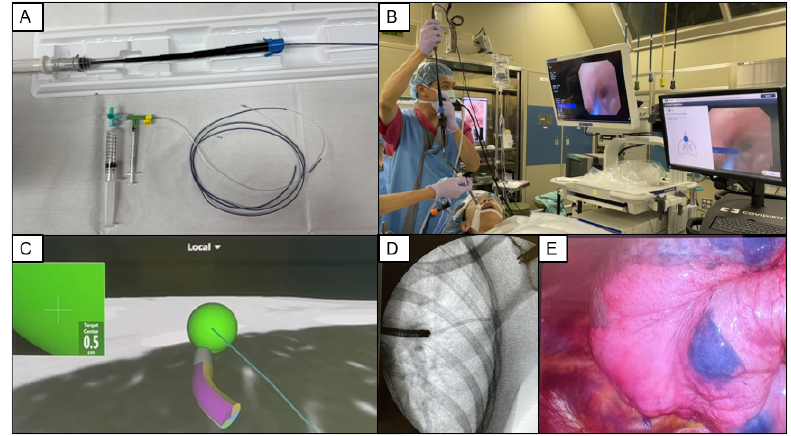
Figure 2. Steps of electromagnetic navigation bronchoscopy virtual-assisted lung mapping. ( A ) Locat- able guide (LG)-containing sensor and metal-tipped catheter are used for electromagnetic navigation bronchoscopy (ENB) lung mapping. ( B ) The LG is inserted in an extended working channel (EWC) and advanced through the target under real-time navigation. ( C ) Once the LG/EWC reaches the target in the virtual image, the EWC is locked in place, and the LG is removed. ( D ) A metal-tip catheter preloaded with 0.7 mL of indigo carmine is inserted into the EWC under fluoroscopic guid- ance. ( E ) The introduction of ENB to virtual-assisted lung mapping makes it possible to perform the preoperative mapping and surgery consecutively in an operating room during the same session of general